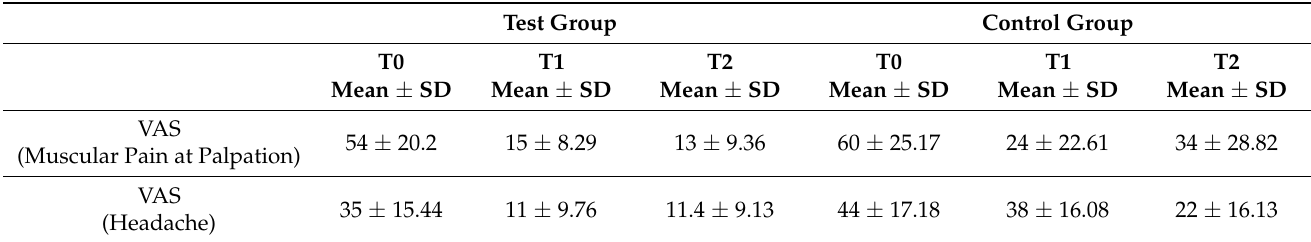
Table 1. Descriptive statistic for muscular pain at palpation and headache. VAS scores mean ± standard deviation (SD).